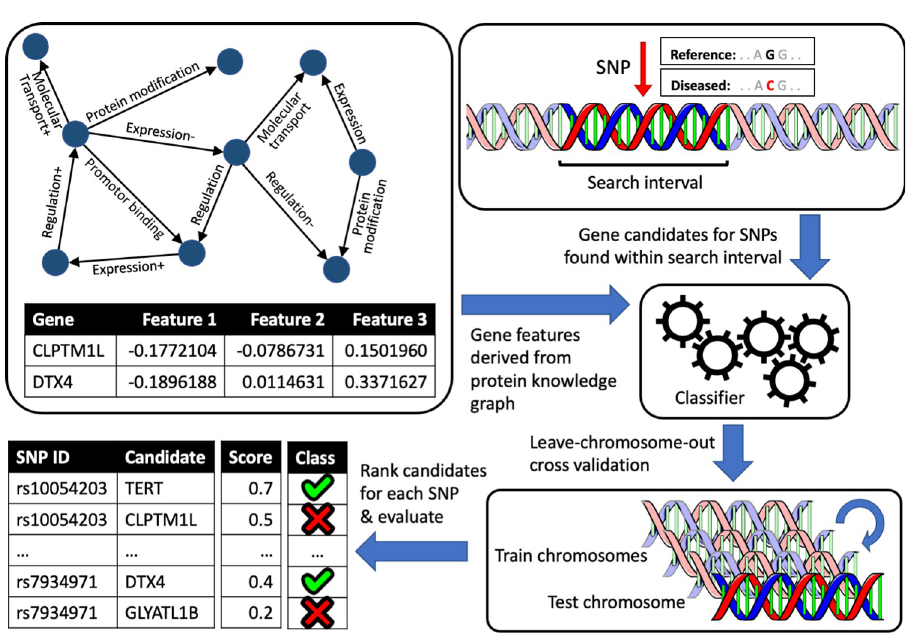
Fig 1. Overview of the experimental process. A feature vector is created for every gene based on the protein interactions in the knowledge graph. The figure shows features generated with node2vec. Simultaneously, the gene candidates for every SNP are identified based upon their proximity to the SNP on the genome. The size of the interval can either be pre-defined, e.g. at 50 kb, or be determined by DEPICT based upon the linkage disequilibrium of the SNP with other SNPs as found in the HapMap or 1000 genomes project data. Based upon the positive and negative cases in each reference set, a classifier is trained and evaluated using the leave-chromosome-out methodology, where all SNP- gene pairs on one chromosome are used as a test set while those on the other chromosomes are used as the training set. All candidate genes for a SNP on the test chromosome are assigned scores by the classifier, based upon which the candidates are ranked. Finally, the ranking of gene candidates for every SNP is evaluated using the reference